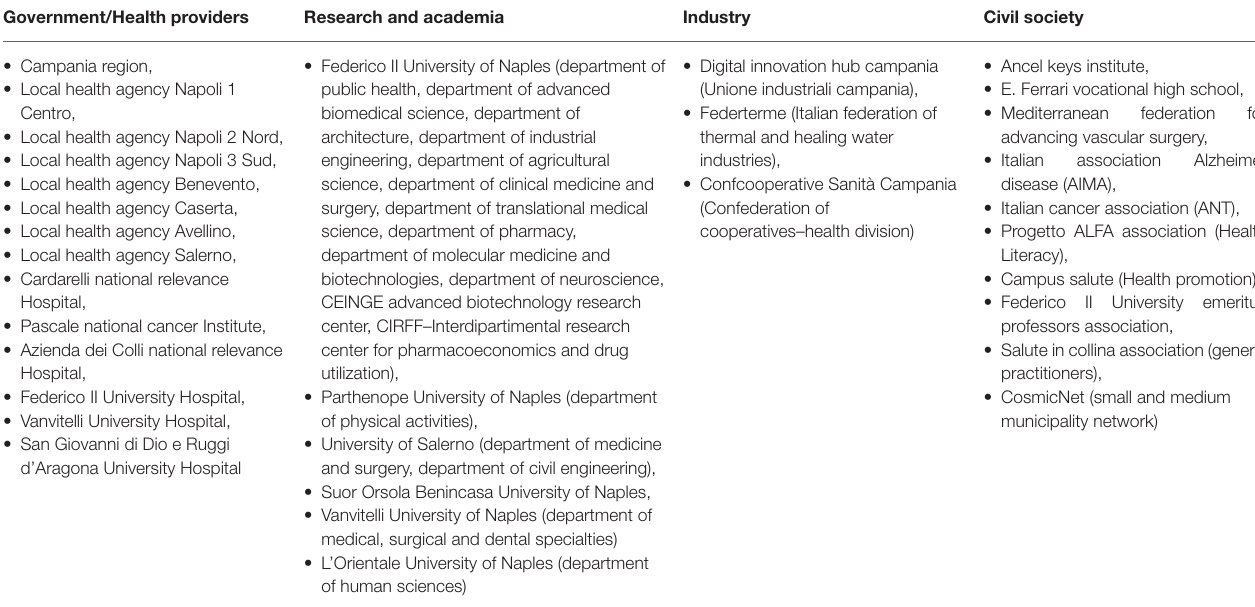
TABLE 1 | The stakeholders of Campania RS along the four helixes of innovation.